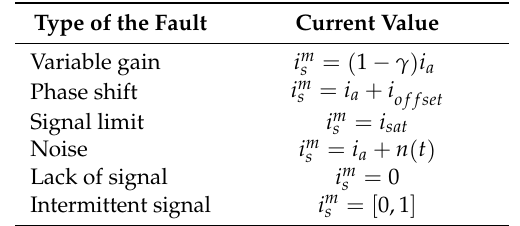
Table 1. Basic faults types of the current sensor, where i sm is measured current, i a is the real current, n(t) is white noise, γ is the constant value from the range < − 1,1>, i sat is the limited current, ω offset = 10 Hz phase shift, and A is current amplitude.